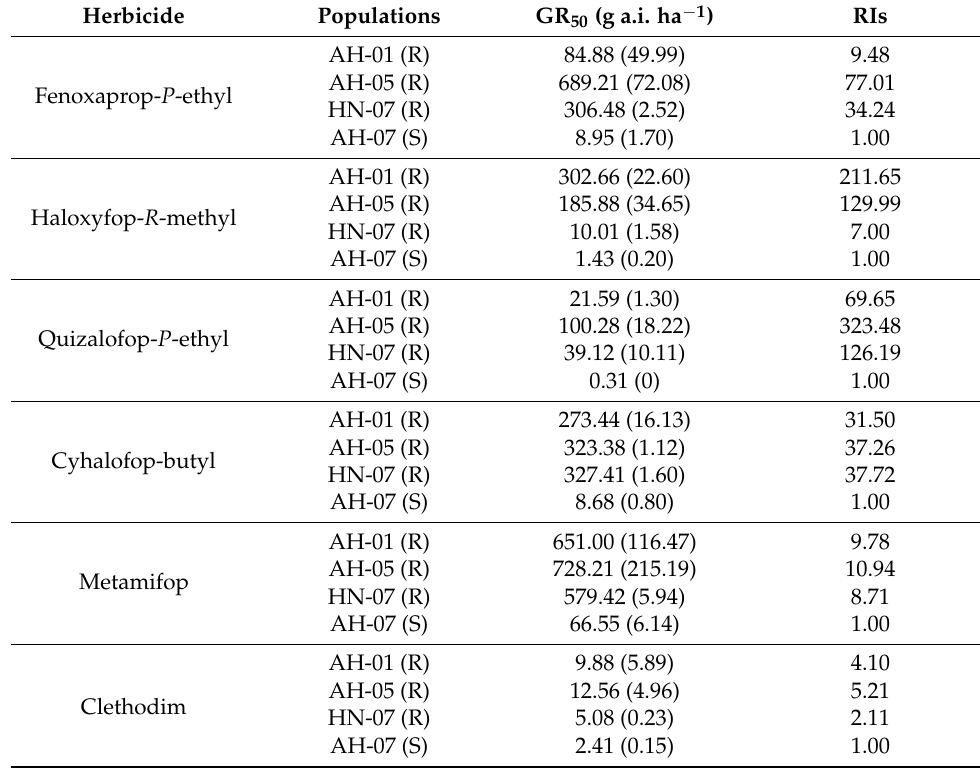
Table 7. The GR 50 values a and Ris b of susceptible (AH-07) and resistant (AH-01, AH-05, and HN- 07) populations of L. multiflorum to different herbicides.